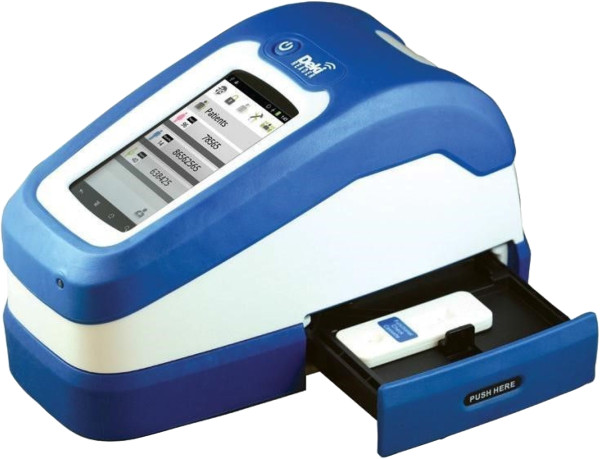
Deki Reader device.